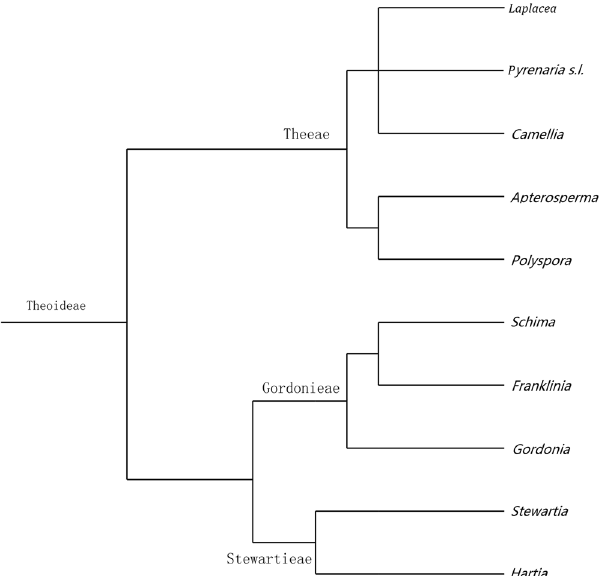
Figure 1. A simplified phylogenetic tree of the Theoideae, drawn by X. G. Shi according the references 10–13 herein using Adobe Photoshop CS5 (Adobe Inc., San Jose, California, USA).